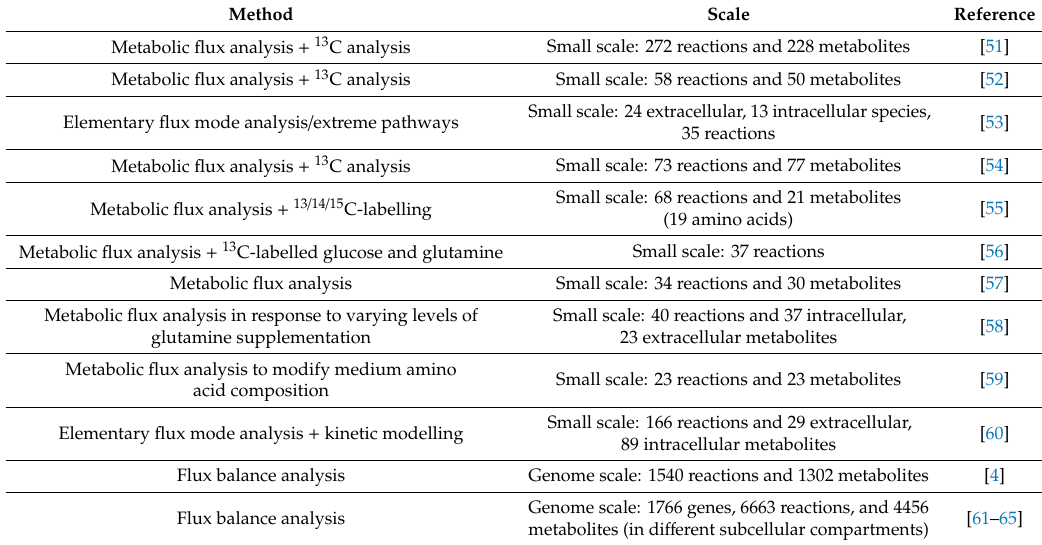
Summary of the available stoichiometry-based models employed in recombinant protein-producing CHO cell medium development and